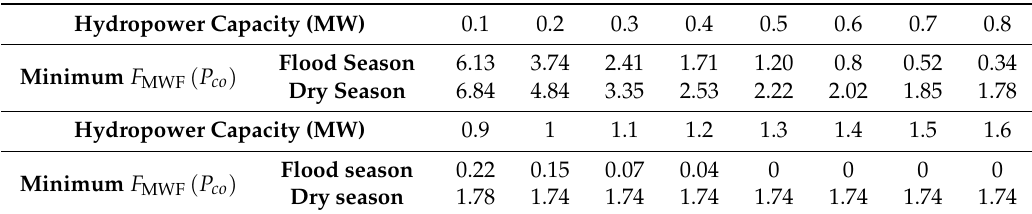
Table 4. Minimum F MWF ( P co) values corresponding to various hydropower capacity and water resource